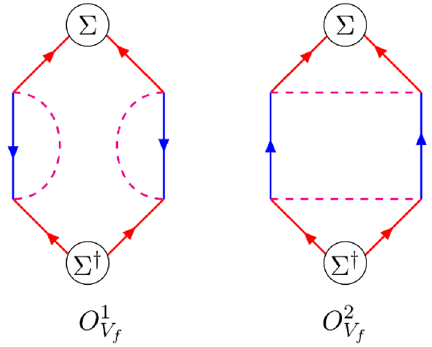
and O 2 in eq. (4.19), contributing to the V f V f